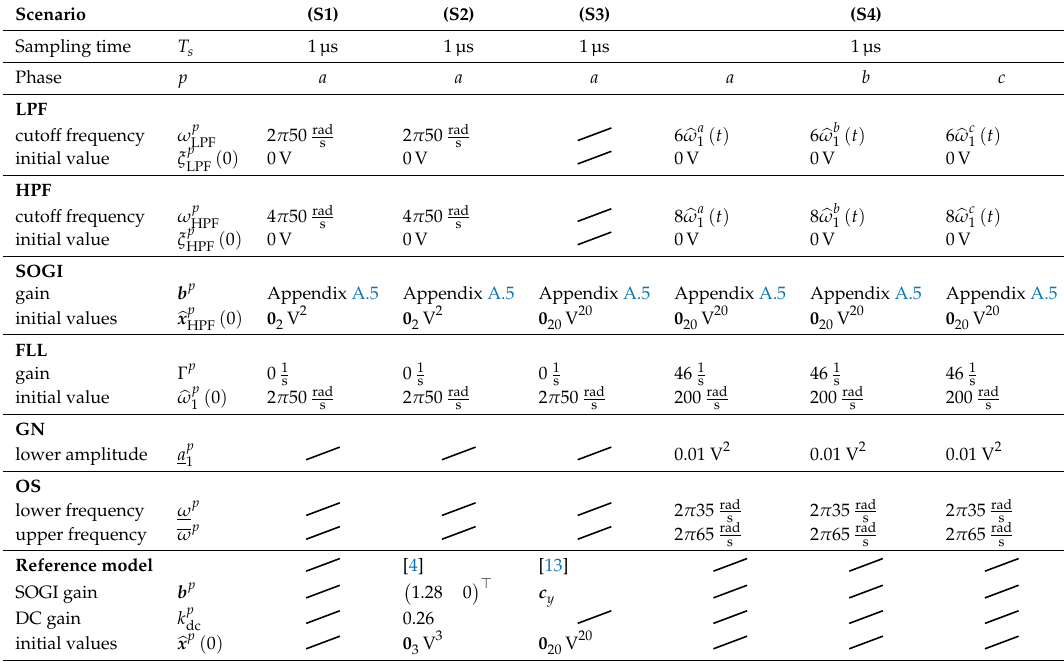
Table 3. System parameters for Scenarios (S1), (S2), (S3), and